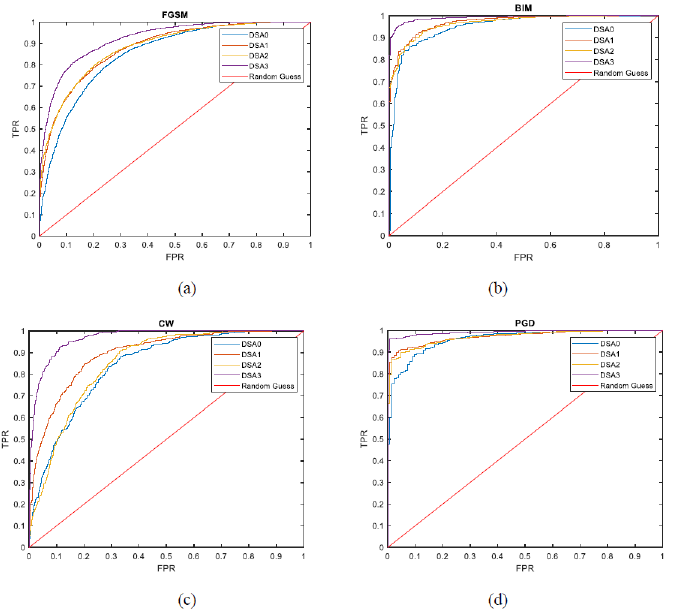
Figure 9. ROC of using DSAs on corner case data detection on four adversarial testing data. ( a ) FGSM. ( b ) BIM. ( c ) CW. ( d )